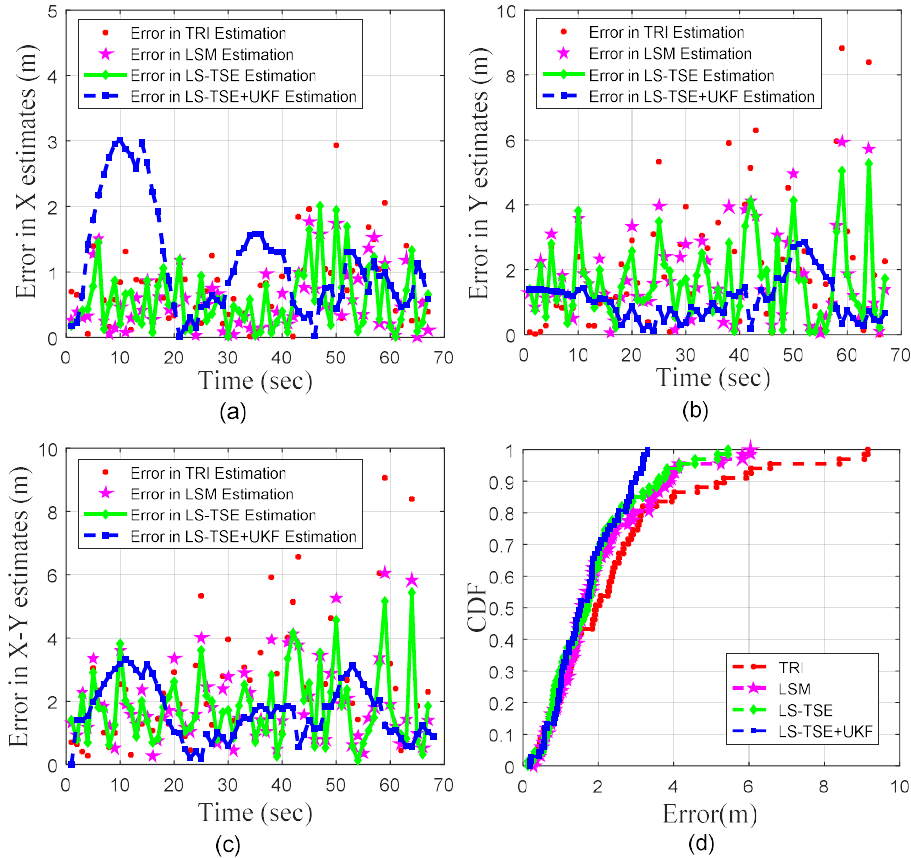
Figure 10. Comparison of Localization errors: ( a ) X axis; ( b ) Y axis; ( c ) X-Y axis; ( d ) CDFs of 2-dimensional location errors.